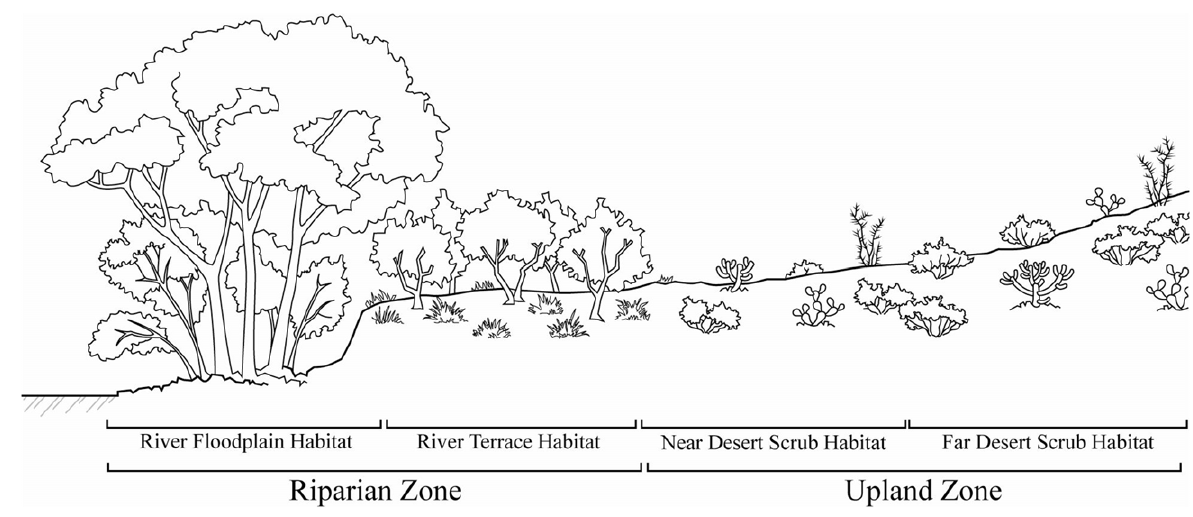
Figure 2. Schematic of the riparian–upland gradient. Note the four habitat types and two zones located along the upper San Pedro River.